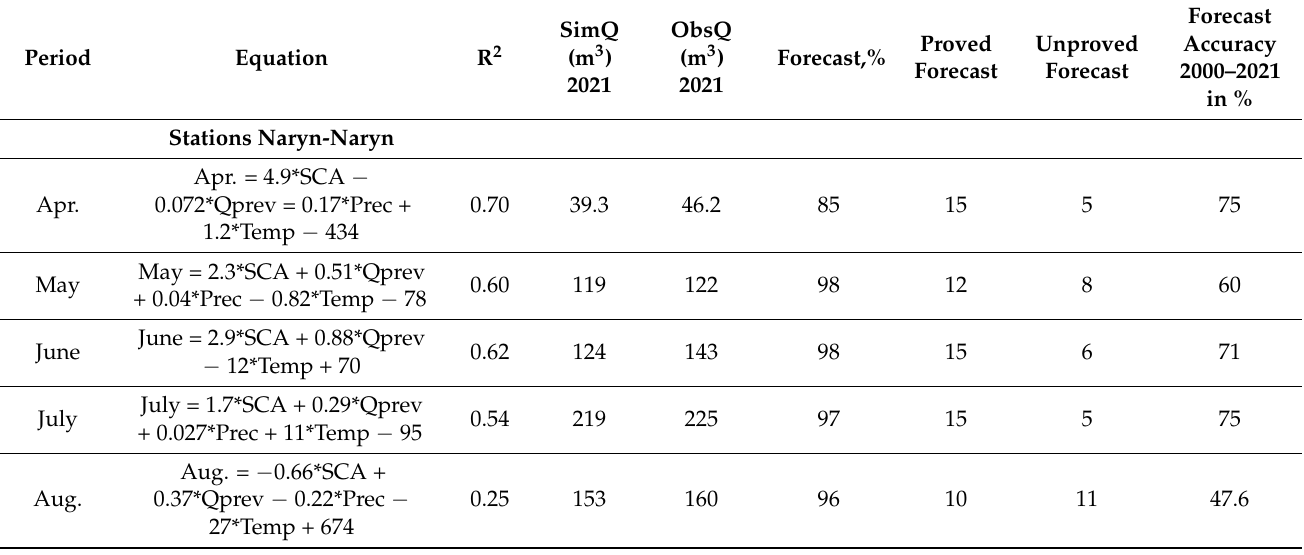
Table 1. Linear forecast models for Monthly and vegetation period